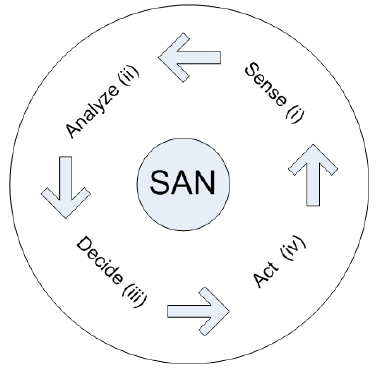
Figure 7. Self aware networks